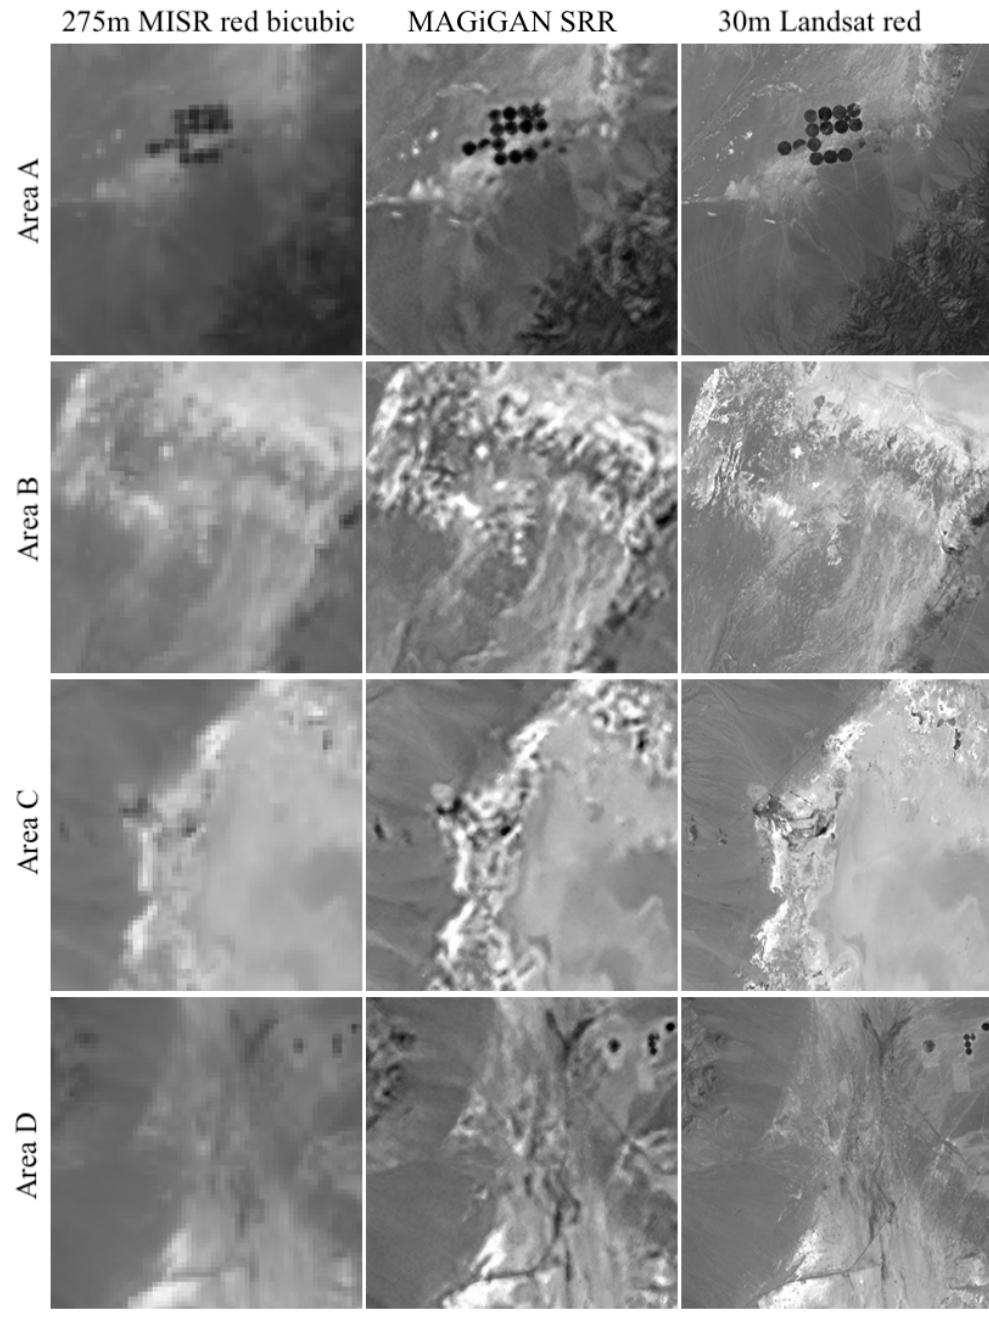
Figure 3. MISR red band SRR results at Railroad Valley in comparison with the original 275m MISR red band image (bicubic interpolated to the same scale as SRR image) and 30m Landsat red band image. Table 1 shows the statistics of the image quality metrics for the bicubic interpolated MISR red band input reference image, SRR results, and the Landsat 7 red band validation reference image for the 4 areas (A, B, C, D) of the first test site at Railroad Valley. The Landsat 7 red band validation image is used as the reference image for calculating the PSNR and mean SSIM value of the MISR and SRR image. The SRR images achieved higher PSNR for Areas A, C, and D compared to the bicubic interpolated MISR images. The PSNR of the SRR image is slightly lower for Area B compared to the bicubic interpolated MISR image. However, the PSNR measurement is inconclusive as it is based on pixel wise differences with respect to a much higher resolution “truth” and it is not able to